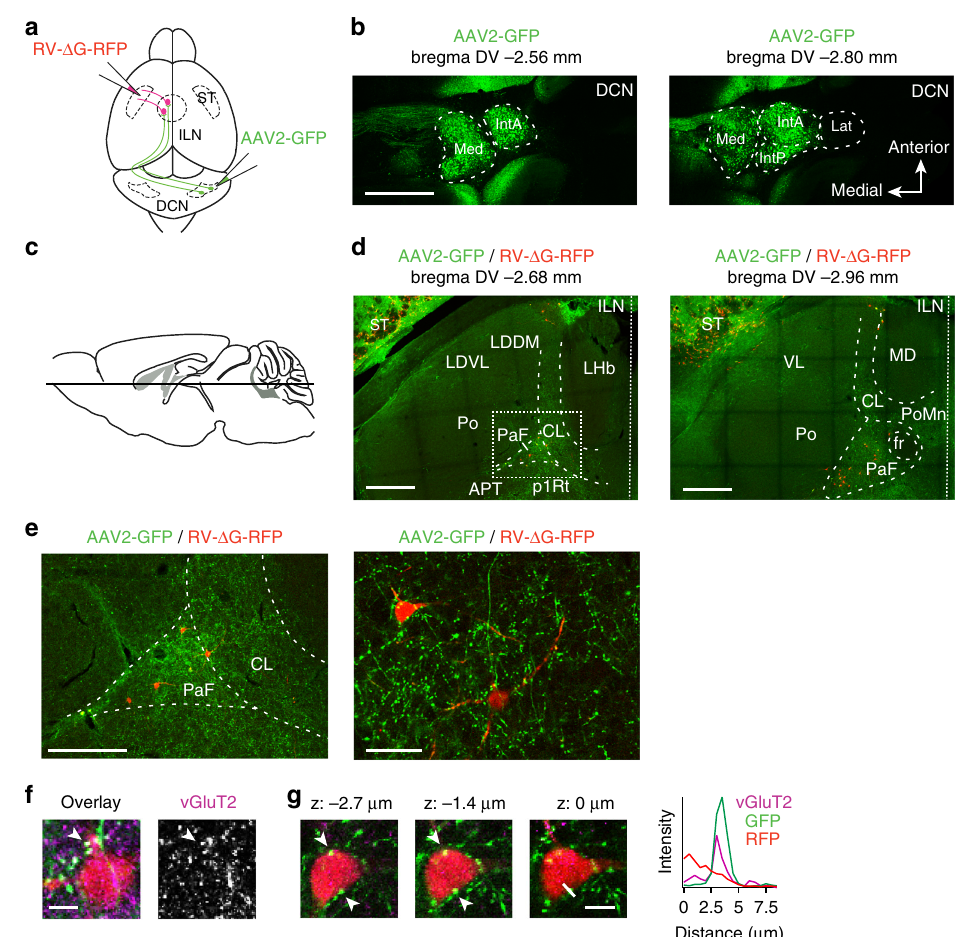
Fig. 1 Excitatory connections from the deep cerebellar nuclei to the striatum. a Stereotaxic injection scheme in P18 mice. A glycoprotein-de fi cient retrograde rabies virus (RV- Δ G-RFP) was injected into the dorsal striatum of one hemisphere and an adeno-associated virus (serotype 2; AAV2-GFP) expressing GFP under the control of the human synapsin promoter was injected into the contralateral deep cerebellar nuclei (DCN). b Primary AAV2-GFP infection sites in the DCN is con fi ned to medial cerebellar nuclei (Med) and interposed cerebellar nuclei (IntA, IntP), but does not extend to the lateral nucleus (Lat). Two dorso-ventral (DV) planes are shown with the position relative to bregma indicated. Scale bar: 1 mm. c Scheme of horizontal section planes used for the analysis. d Example images of intralaminar thalamic nuclei (ILN) at two different dorsal – ventral planes. GFP-positive axons are concentrated in several ILN substructures, including the centrolateral thalamic nucleus (CL), parafascicular thalamic nucleus (PaF) as well as the ventrolateral thalamic nucleus (VL). Note that the fl uorescence seen in the striatal area (ST) is tissue auto fl uorescence. Thalamic neurons retrogradely labeled from the dorsal striatum with RV- Δ G-RFP are mostly observed in PaF and CL. The dashed rectangle marks the region enlarged in e . Scale bar: 500 µ m. e Enlargement of ILN area. GFP-positive axons from DCN form varicosities onto RFP-positive neurons back-labeled from the dorsal striatum. Scale bars: 250 µ m and 50 µ m, respectively. f Some GFP-positive varicosities (arrow head) located on dendrites of RFP-positive cells are vGluT2-positive, indicating the presence of synaptic terminals. Scale bars: 10 µ m. g Fluorescence intensity measurement demonstrating the alignment of a GFP- and vGluT2- positive varicosity apposed to a retrogradely marked RFP-expressing thalamic cell. Several consecutive optical sections from a z-stack are displayed. Scale bars: 10 µ m. All experiments in this fi gure were replicated in three mice per condition. Anatomical annotations: APT anterior pretectal nucleus; fr fasciculus retro fl exus; LDDM laterodorsal thalamic nucleus, dorsomed; LDVL laterodorsal thalamic nucleus, ventrolateral; LHb lateral habenular nucleus; MD mediodorsal thalamic nucleus; Po posterior thalamic nuclear group; PoMn posteromedian thalamic nucleus; pIRt- prosomere 1 reticular format; ST striatum; VL ventrolateral thalamic DCN-striatum connections target iMSNs and ChAT inter- observed when either one of the two tracing viruses was injected neurons . Thalamic neurons in CL and PaF project to both alone (Fig. 2d). Notably, ILN neurons anterogradely labeled from the cortex and the striatum 32 . To map the axonal targets of the cerebellum project densely to several cortical and striatal areas intralaminar neurons (ILN) which receive inputs from inter- (Fig. 2e). In the neocortex we observed dense axon projections to posed/medial DCN, we expressed in the DCN the anterograde motor and somatosensory cortices (M1, S1, S2; Fig. 2e). Strik- transneuronal tracer wheat germ agglutinin (WGA) fused to cre- ingly, we also observed axonal projections to areas implicated in recombinase 33 and a cre-dependent marker (AAV2-DiO- higher brain functions such as the cingulate cortex (A24) and the mCherry) in the intralaminar thalamic nuclei (Fig. 2a, b). Four frontal associate cortex (FrA) (Fig. 2e). Axonal coverage by the weeks after injection we observed abundant mCherry positive DCN-ILN-derived projections in the dorsolateral and dorsome- cells in CL and PaF, indicating ef fi cient transneuronal transfer of dial striatum was similar to motor and primary sensory cortices cre-recombinase (Fig. 2c and inset). No signi fi cant signal was (Fig. 2f). Thus, in mice, disynaptic cerebello-striatal connections